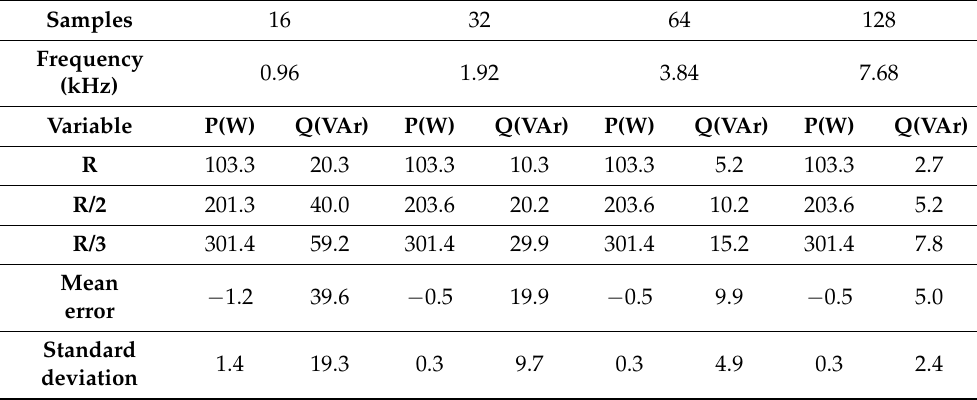
Table 4. CPT powers for resistive loads for 16, 32, 64 and 128 samples per cycle.